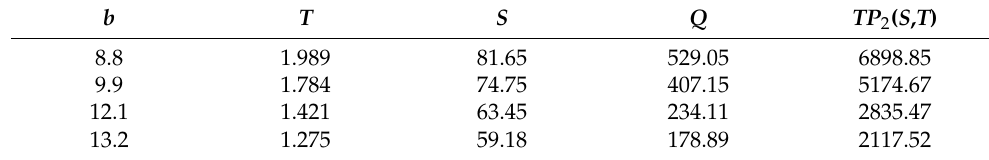
Table 4. Impact of price sensitivity factor ( b ) .